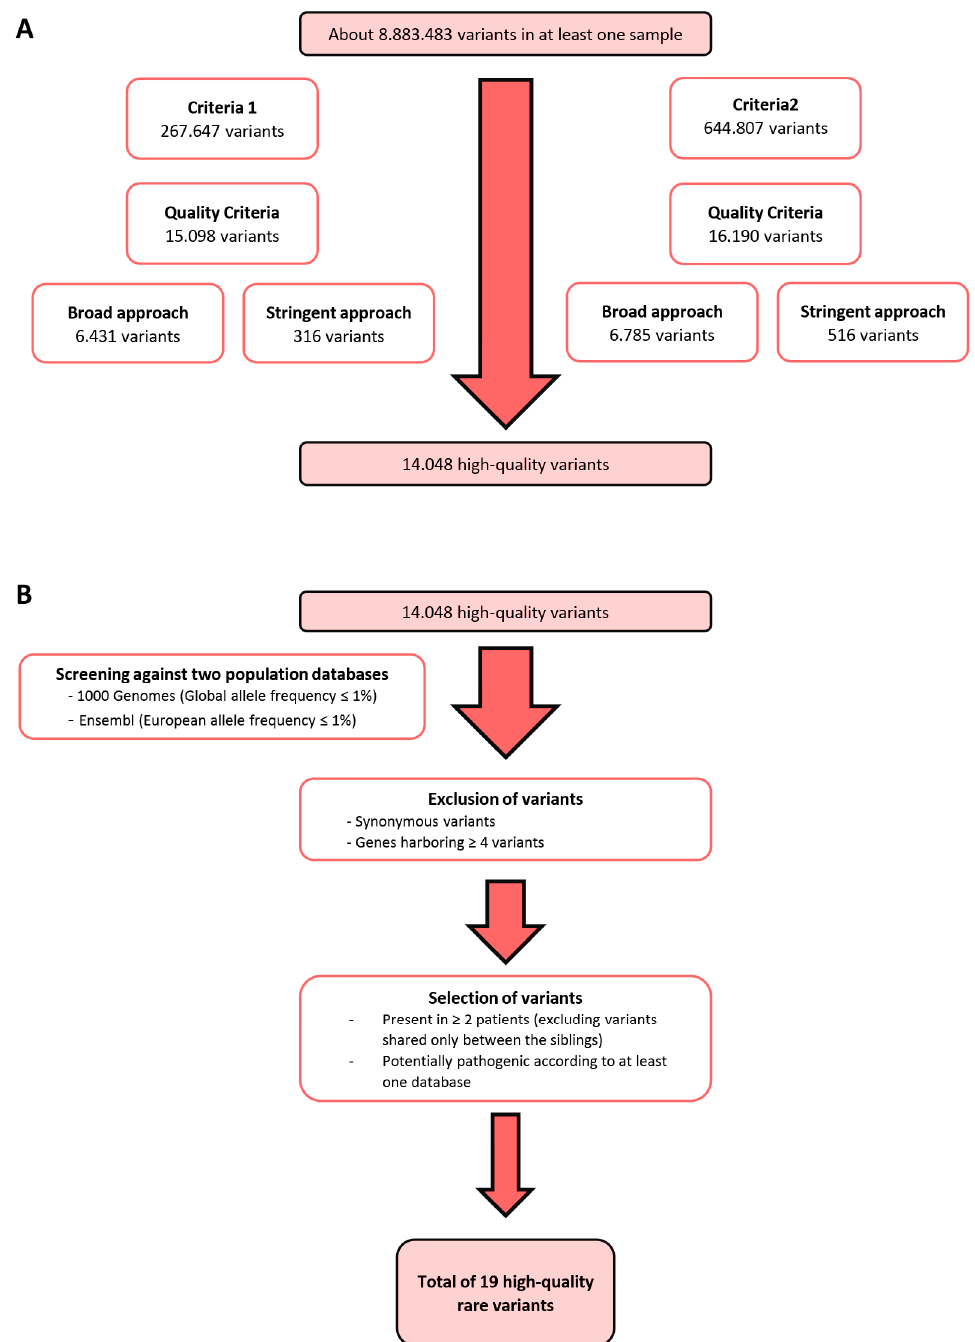
Figure 1. Variant selection. ( A ) Bioinformatics analysis was conducted using two criteria: Criteria 1 included potentially altered variants detected in two siblings and at least one other patient; Criteria 2 included potentially altered variants detected in at least two patients, excluding siblings. Only high-quality variants were included, and two approaches were used: A “broad approach” selecting only exonic variants and a “stringent approach” selecting exonic and intronic variants that had high quality, clinical significance, or predicted damaging effects. ( B ) Exclusion of variants with an allele frequency higher than 1% in the global and European populations, synonymous variants, and genes harbouring four or more variants, followed by selection of variants present in more than two patients and potentially pathogenic according to at least one database.